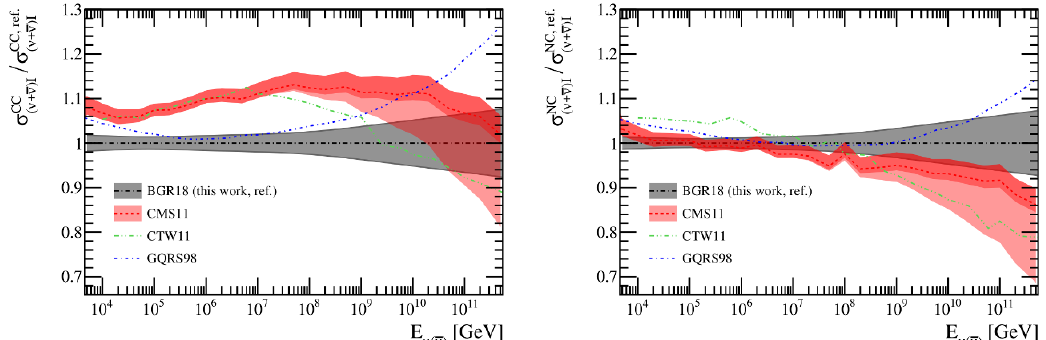
Figure 14 . Comparison of the results of the present work (BGR18) with previous calculations of the UHE neutrino-isoscalar cross-sections as a function of E for CC (left) and NC (right plot) (cid:23) ((cid:22) (cid:23) ) scattering, normalised to the central BGR18 value. The BGR18 predictions are provided in the n f = 6 FONLL scheme at NNLO+NLL x accuracy with the corresponding NNPDF3.1sx+LHCb PDF set, and are compared to the GQRS98, CMS11, and CTW11 calculations. For both BGR18 and CMS11 the bands indicate the PDF uncertainty and in the CMS11 case the dark and light bands correspond to two alternative treatments of the PDF uncertainty, see